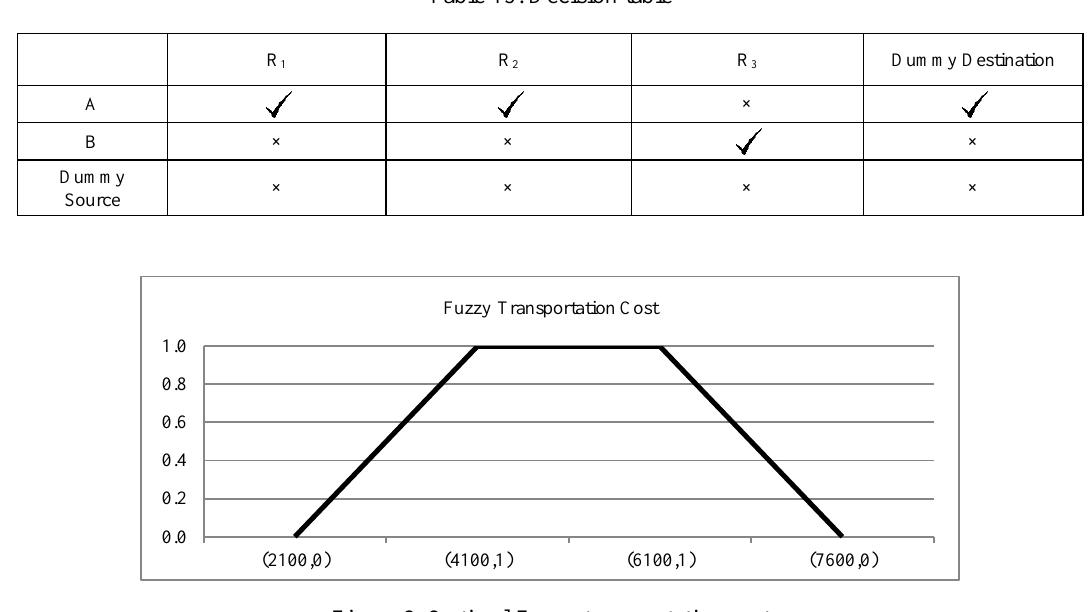
Figure 2. Optimal Fuzzy transportation